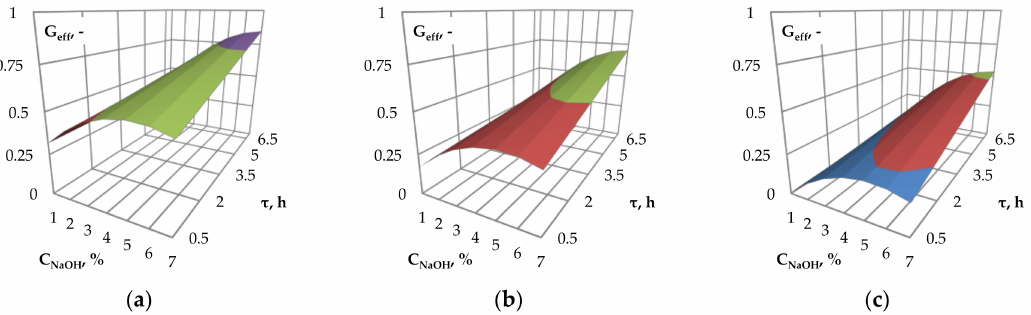
Figure 3. Influence of the catalyst concentration and pre-treatment time on the glucose efficiency for the pre-treatment temperature of 60 ◦ C: ( a ) Granulation 0.25 mm; ( b ) Granulation 2 mm; ( c ) Granulation 4 mm.